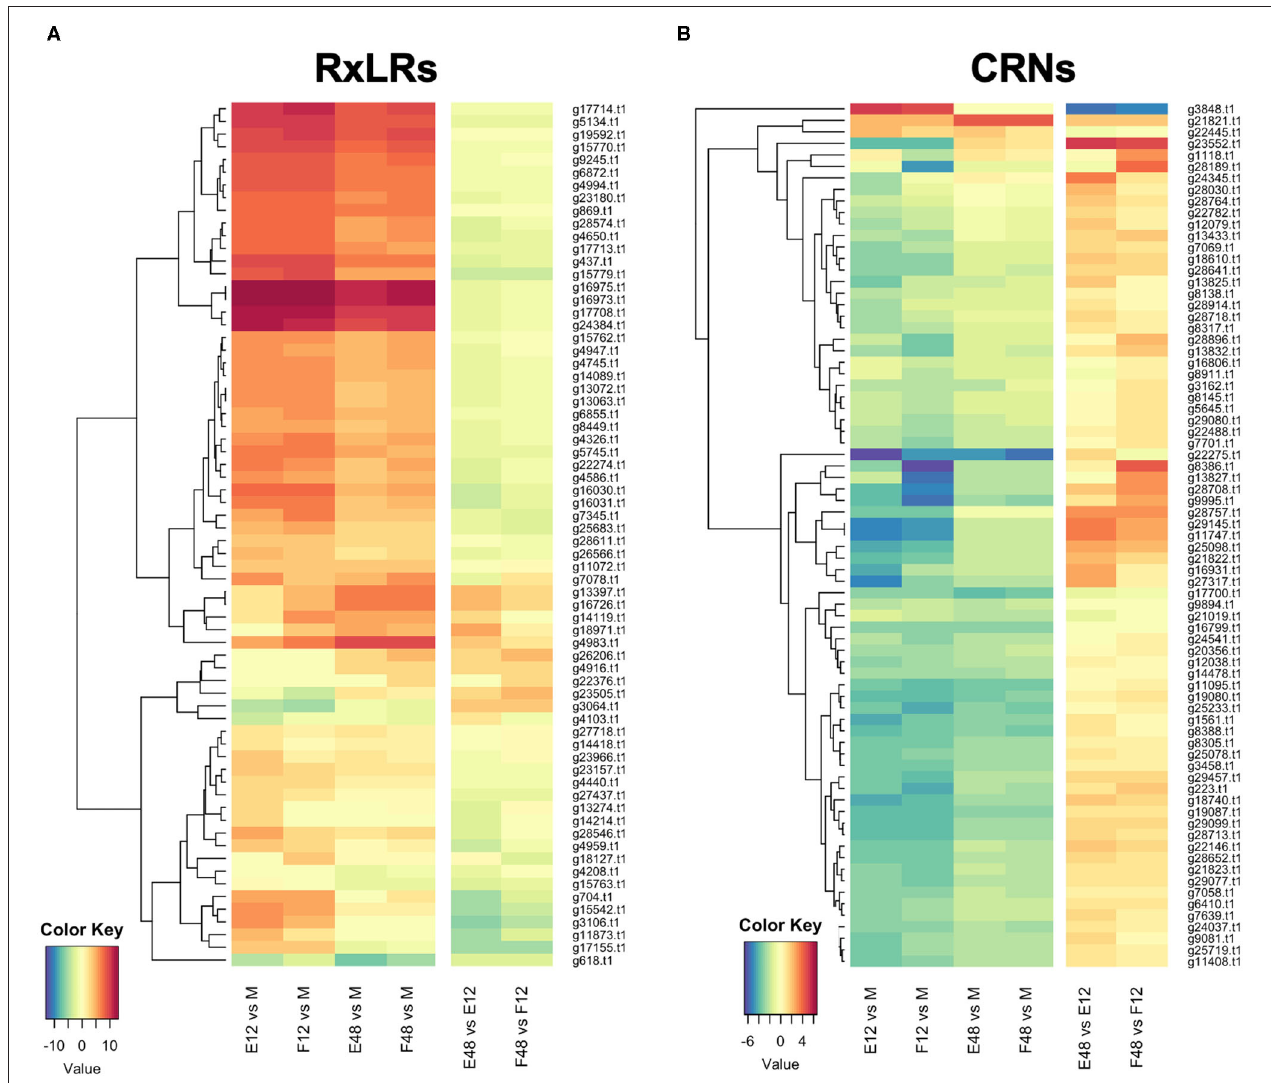
FIGURE 5 | Expression pattern of effectors observed upon infection of both susceptible (‘Emily’) and resistant (‘Fenella’) strawberry roots. RxLR and crinkler (CRN) genes clustered by expression profile. All gene IDs related to the P414 genome ( Pcac1_ ). E, ‘Emily;’ F, ‘Fenella;’ M, mycelia; 12, 12 hours post-inoculation (hpi); 48, 48 hpi. (A) RxLR genes shown in dark red were in the top 25 expressed genes at 12 hpi ranked by log fold change (LFC), (B) the time points investigated don’t appear to have captured differential expression of